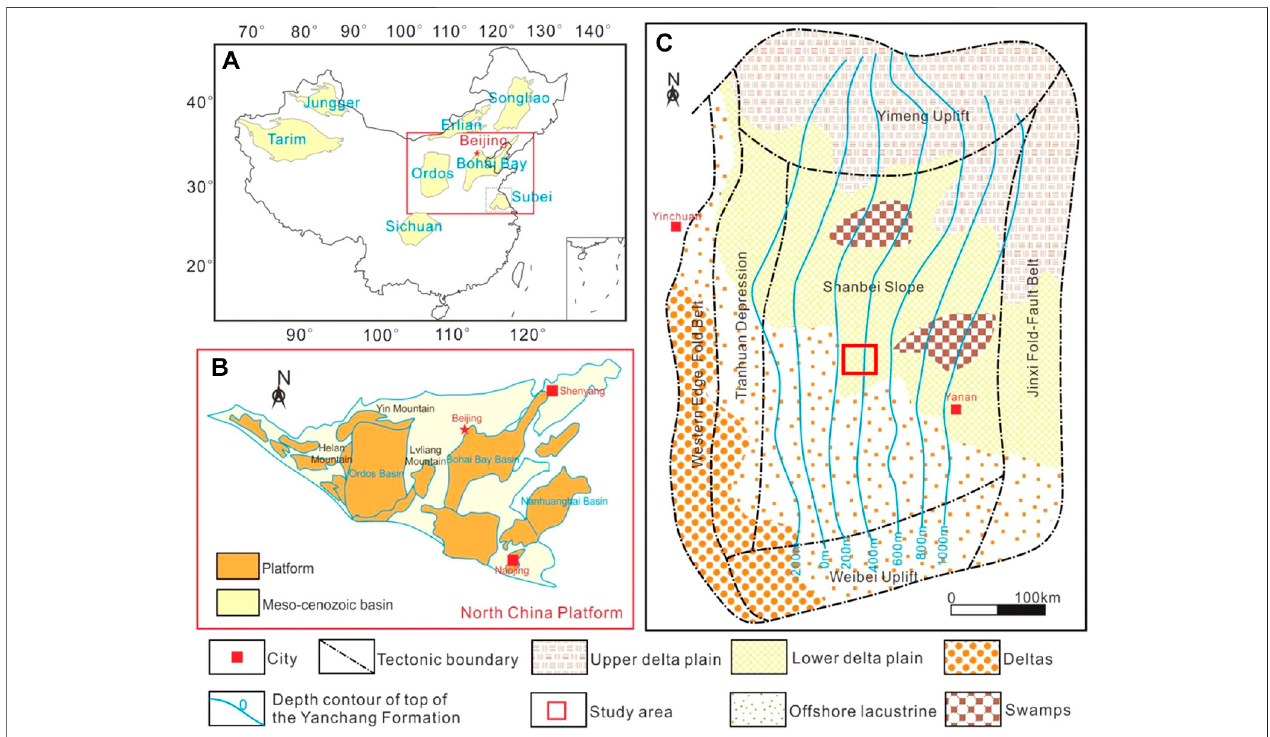
FIGURE 1 | Location of the study area (modi fi ed after Liu Y et al., 2022). (A) The study area is located in the Ordos Basin of the North China Plate; (B) The distribution of sedimentary basins in the North China Plate; (C) The study area is located in the central part of the Ordos Basin.